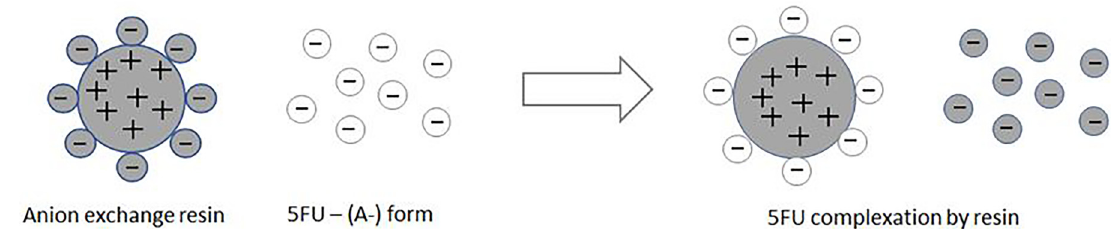
Figure 3: Action mechanism of anion exchange